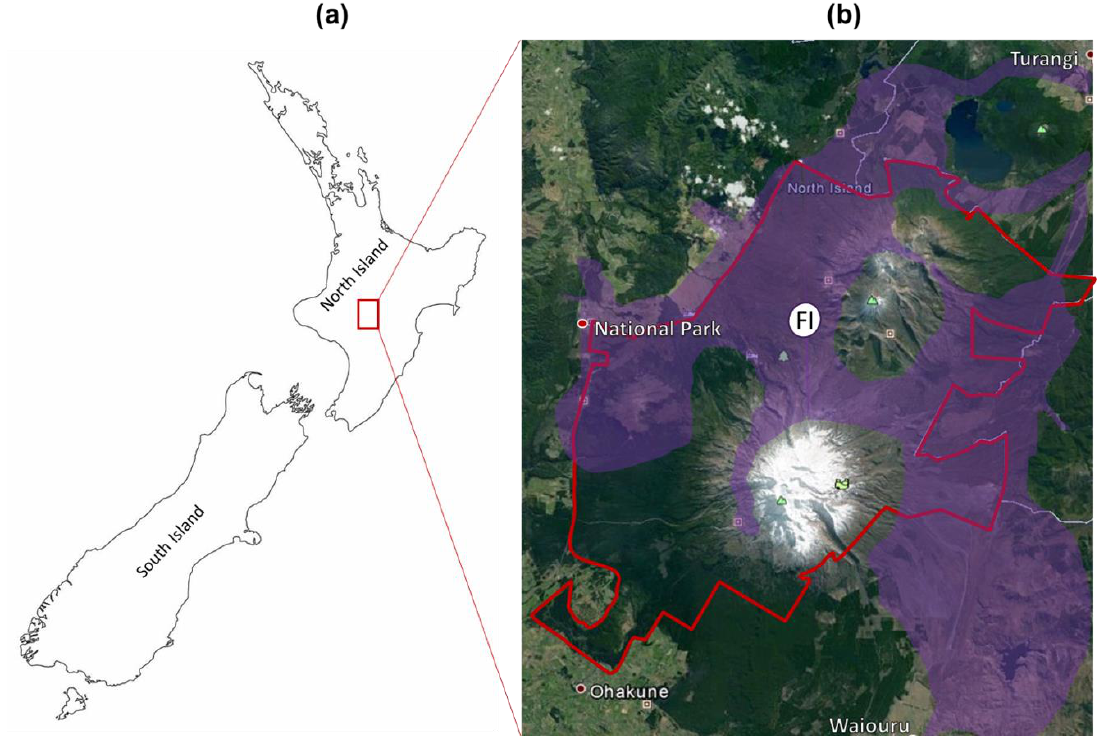
Figure 1. The distribution of heather in the Central North Island. ( a ) North and South Islands of New Zealand. ( b ) Invasion of heather in the Central Plateau. Heather was first planted in the white region (FI) but has now spread through all the regions in purple. The boundary of Tongariro National Park (TNP) is shown in red.